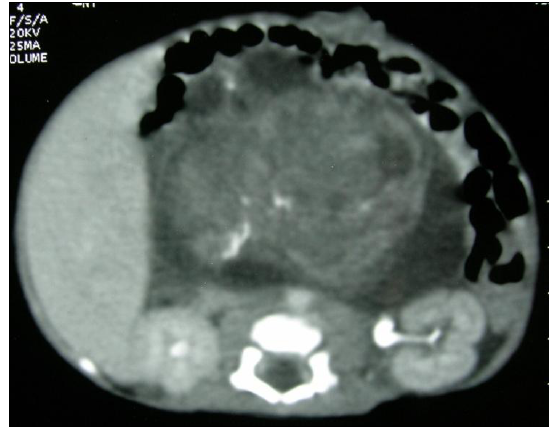
Figure 1: CT scan abdomen showing a large heterogeneous retroperitoneal mass with foci of calcification